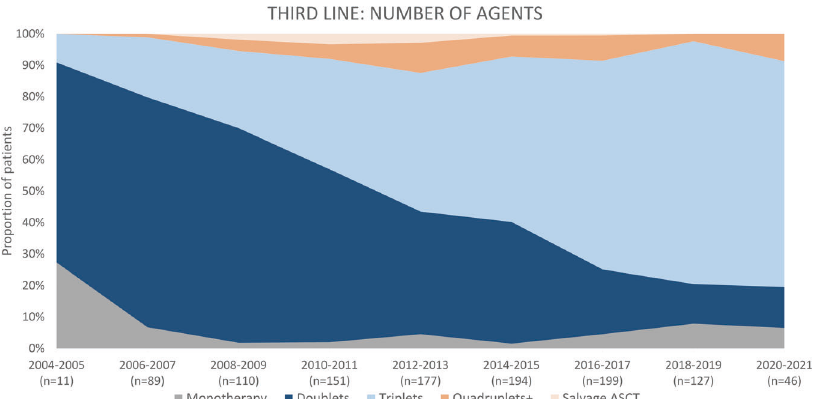
Fig. 6 Number of agents applied as third-line treatment in multiple myeloma patients, initiation of third-line treatment 2004 – 2021. ASCT autologous stem cell transplantation.